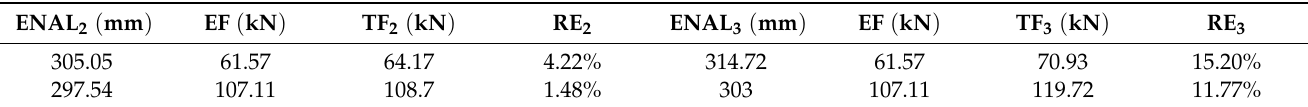
Table 2. Comparison between the measured and calculated prestress forces of the beam.